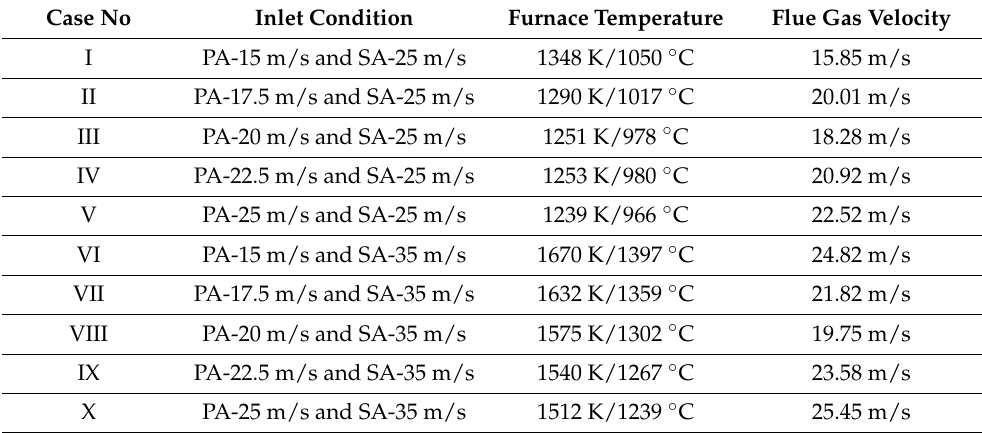
Table 8. Different flue gas temperature and velocity